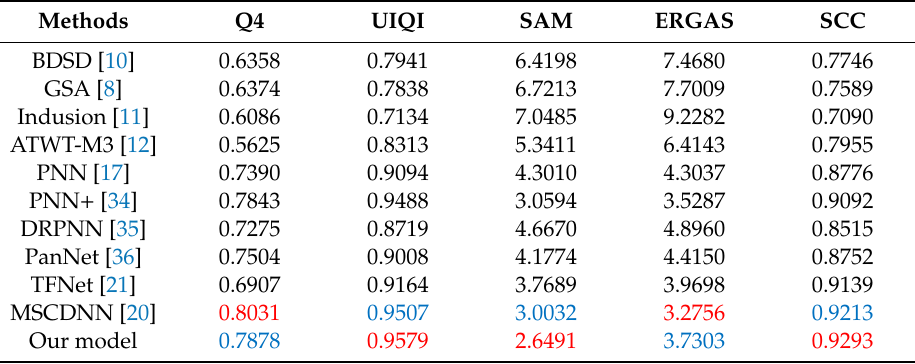
Table 8. Quantitative evaluation results of di ff erent methods on the GaoFen-2 dataset. The best and the second best results are in red and blue, respectively.